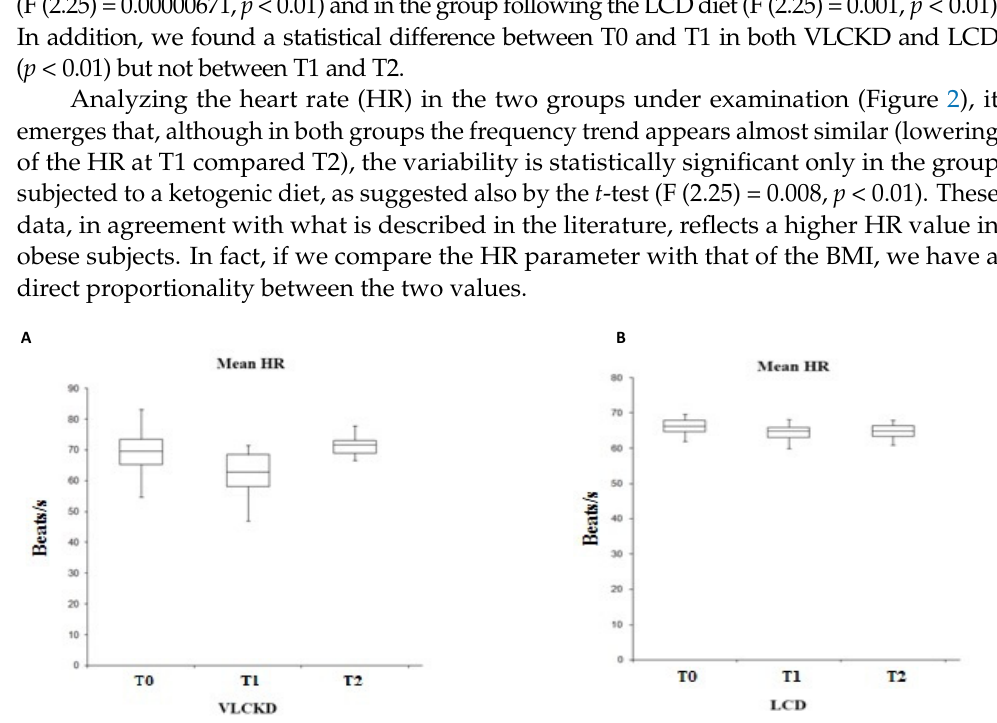
Figure 3 . Variability of the mean R-R in VLCKD subjects (A) and in LCD subjects (B). Analyzing the HF parameter (Figure 4), we find, as expected, a trend similar to that of the RR variability, with a significance in the ketogenic diet group (F (2,25) = 0.002, p < 0.01).